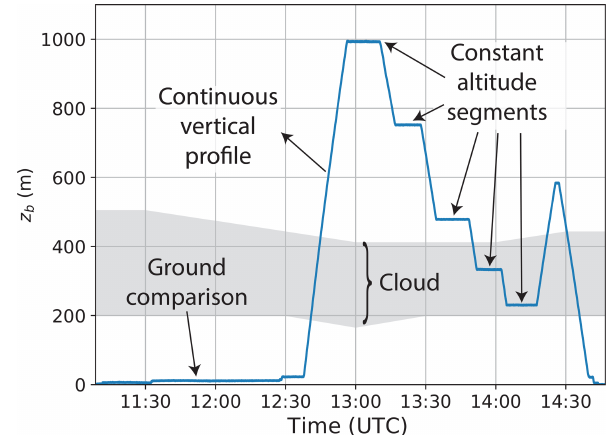
Figure 3. Measurement strategy illustrated by the balloon altitude time series of 5 June 2017. The two approaches are (1) constant alti- tude segments and (2) a continuous vertical profile. The shaded area illustrates the vertical extent of the cloud layer, which is determined from Cloudnet data (Griesche et al.,